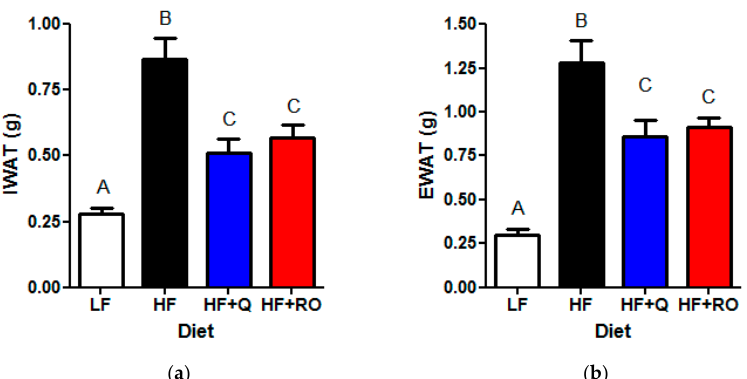
Figure 1. Mice ( N = 10/group) were fed low fat (LF; white), high fat (HF; black), high fat + quercetin (HF + Q; blue) or high fat + ROE (HF + RO; red) diets for 9 weeks and ( a ) inguinal white adipose tissue (IWAT) and ( b ) epididymal white adipose tissue (EWAT) depots were extracted and weighed. Graphs are mean ± SEM. Different letters denote significant differences between groups at p < 0.05.